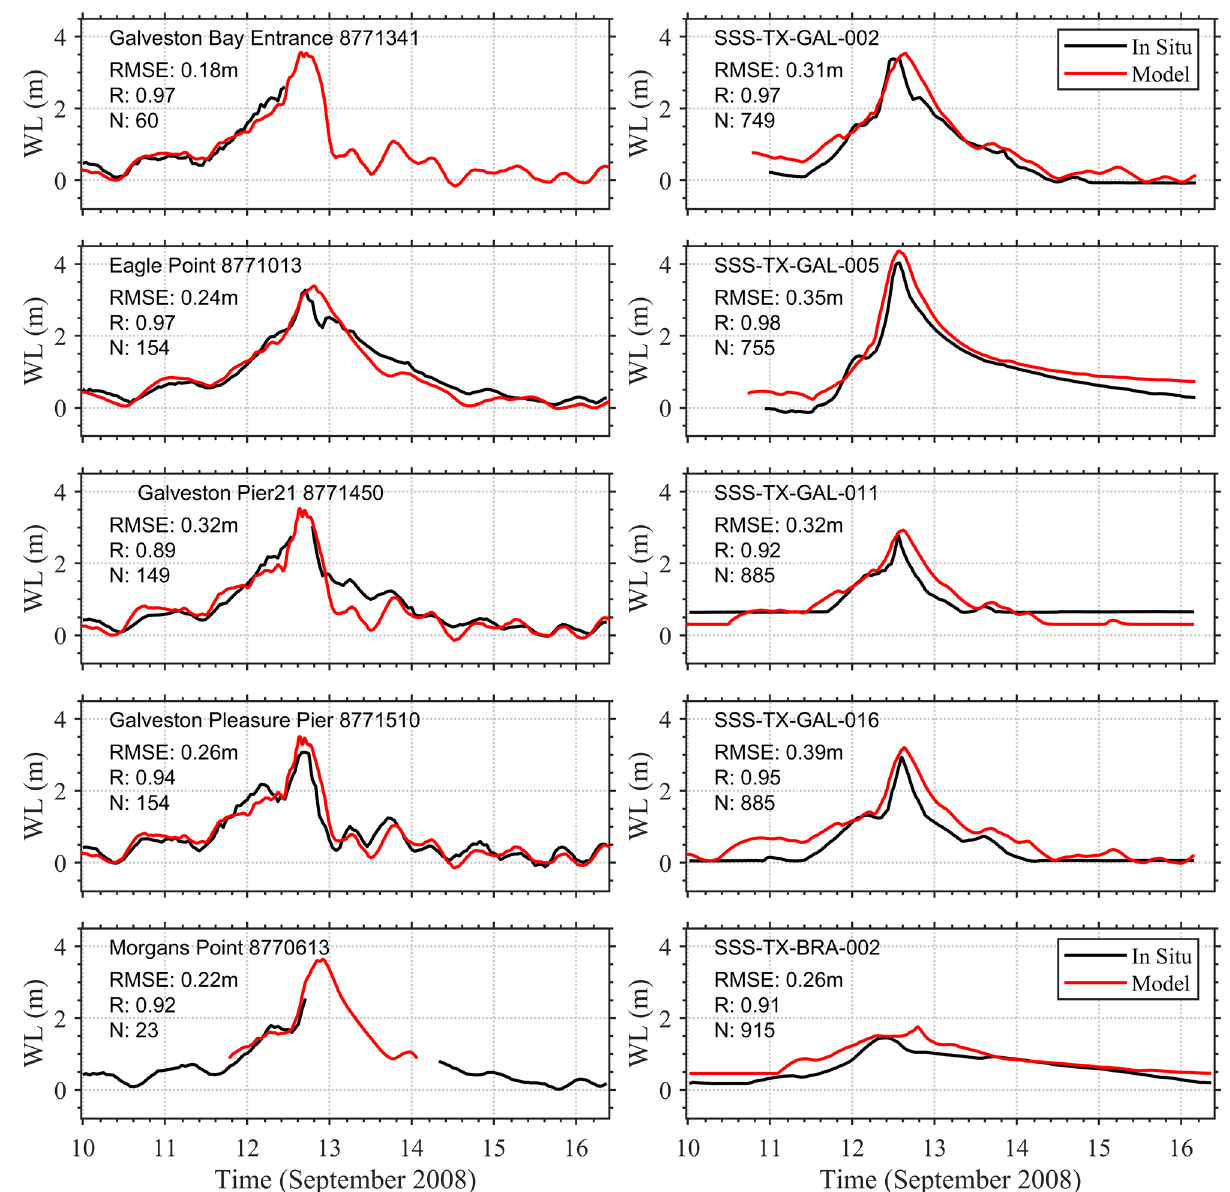
Figure 5. Comparison of total water levels (WL) in Mean Sea Level (MSL) vertical datum between tidal stations (in black) and the storm surge model (in red) at different locations in the study